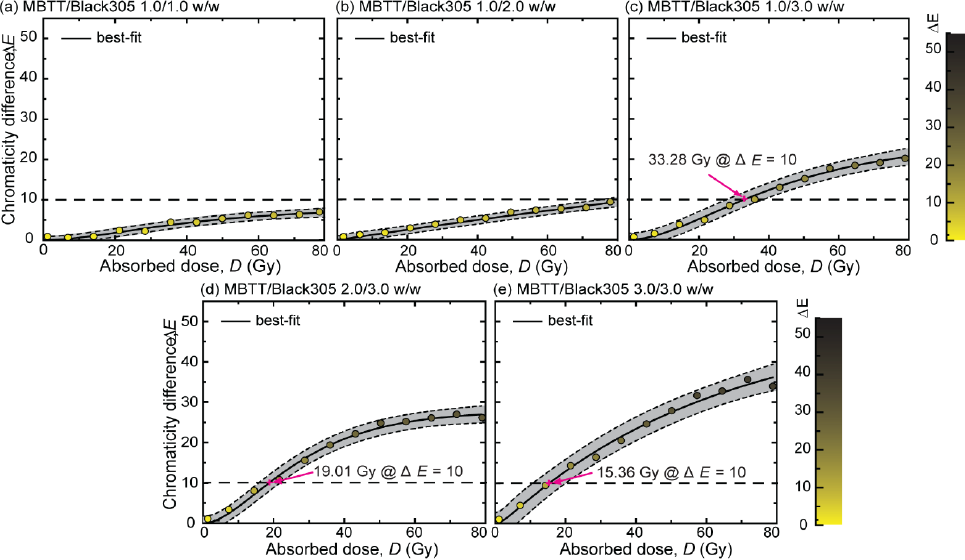
Figure 2. Dose-response curves at 20 °C for the fibrous color dosimeters using the composite fibers prepared under the conditions specified in Table 1. The black dashed line indicates the point at which the color change can be visually observed. The color bar indicates the color tone corresponding to Δ E .